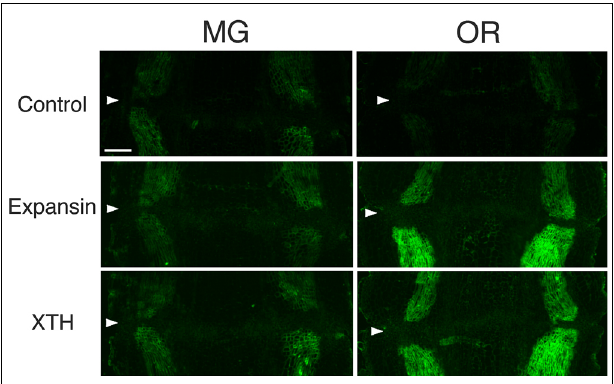
FIGURE 6 | Immunolocalization of expansin and XTH epitopes in the AZs of mature green (MG) and over-ripe (OR) fruit pedicels. Longitudinal sections of MG fruit pedicels, including the AZ, were stained with the anti-expansin and anti-xyloglucan antibodies. Micrographs show the negative control without the first antibody step. Arrowheads indicate the AZs. Bar = 0.5 mm.